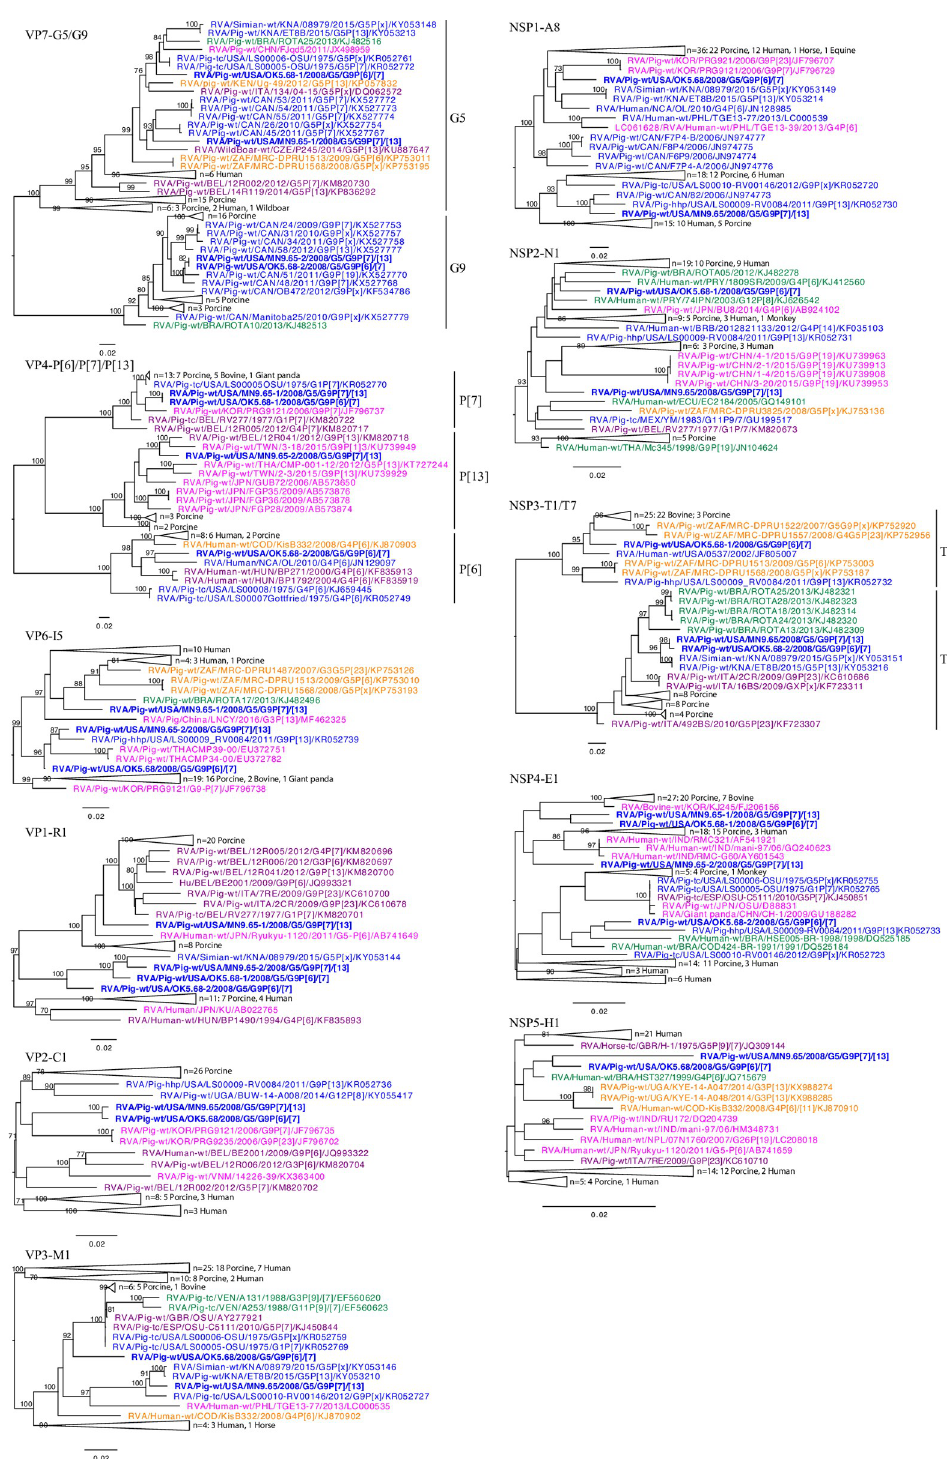
Fig 1. Phylogenetic trees of the RVA strains MN9.65 and OK5.68. The RVA strains from this study are represented in bold. The strains from Asia, North America, South America, Europe, and Africa are colored in pink, blue, green, purple, and orange,